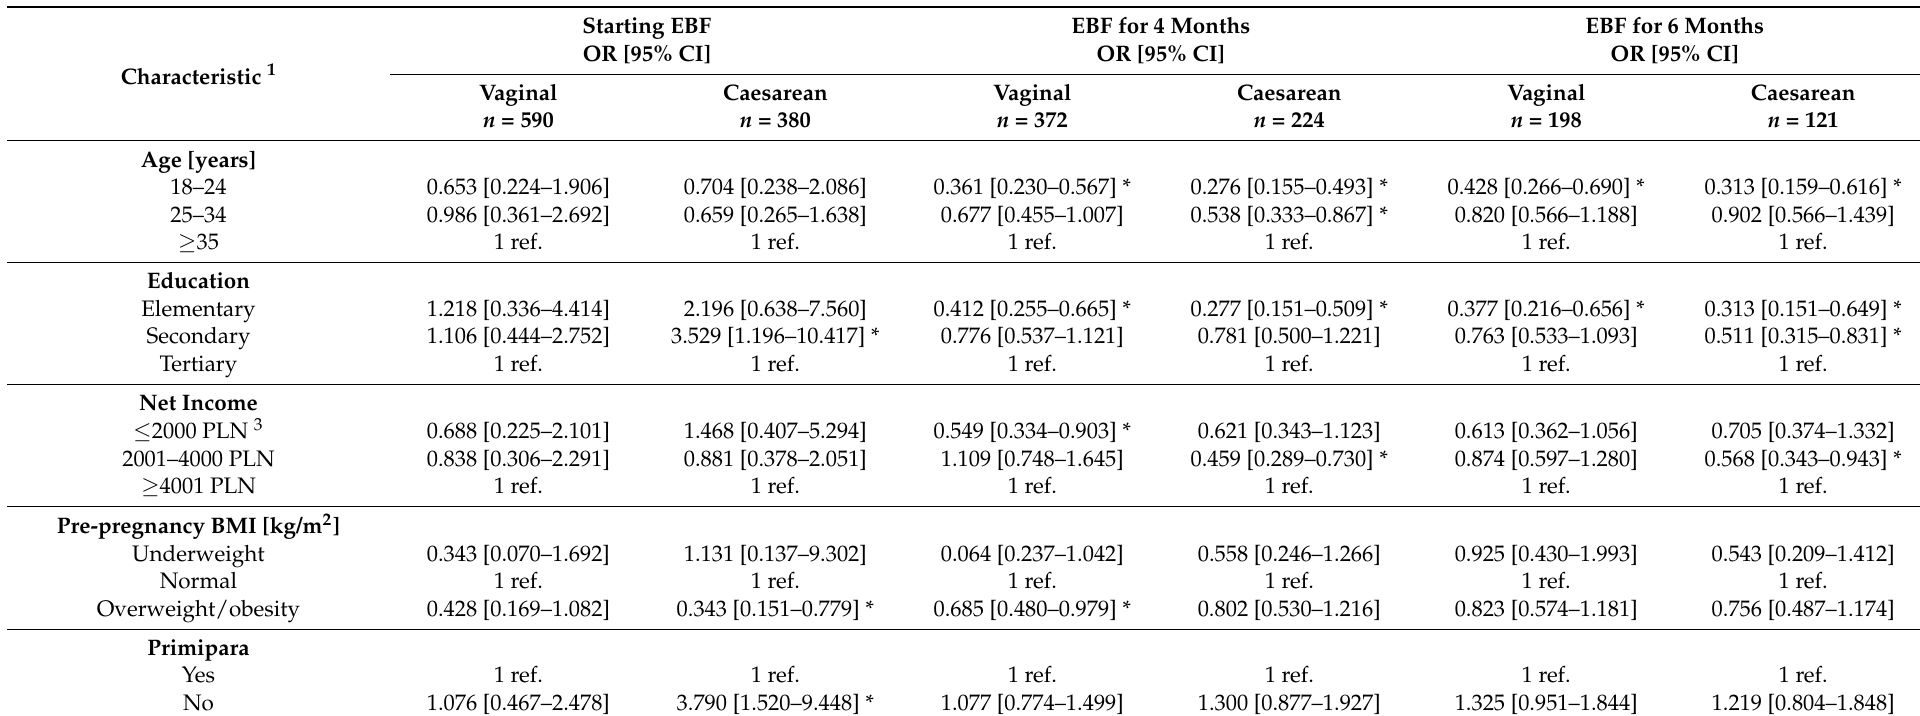
Table 4. The odds ratio (OR) for exclusive breastfeeding (EBF) practice depending on the method of delivery ( n =